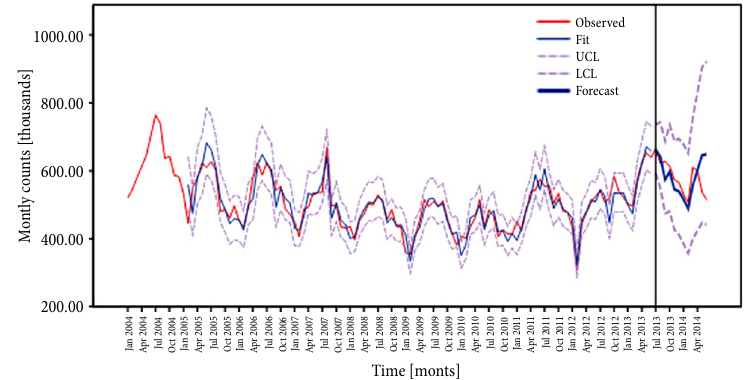
Figure 6. Results of SARIMA forecasting for the passenger demand on Serbian railways